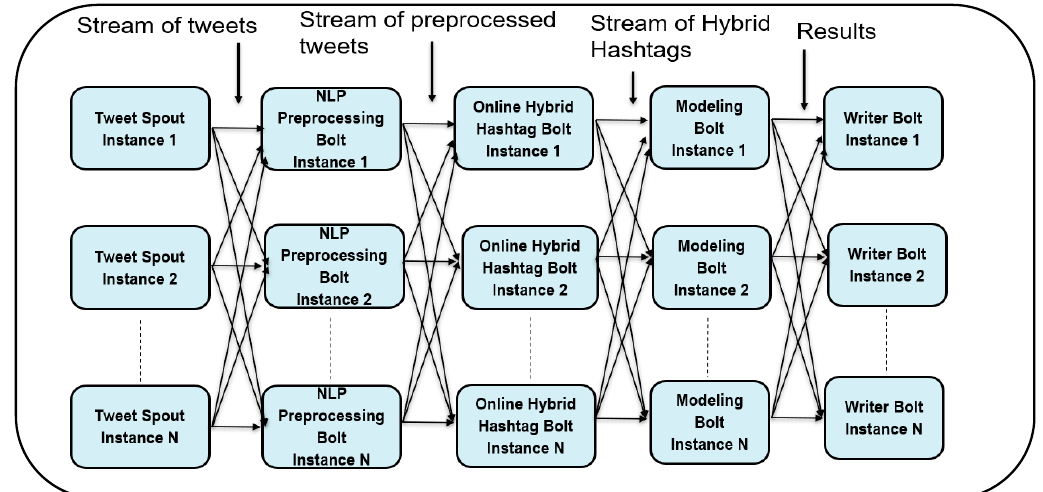
Figure 4. Storm Topology of our proposed HHTC